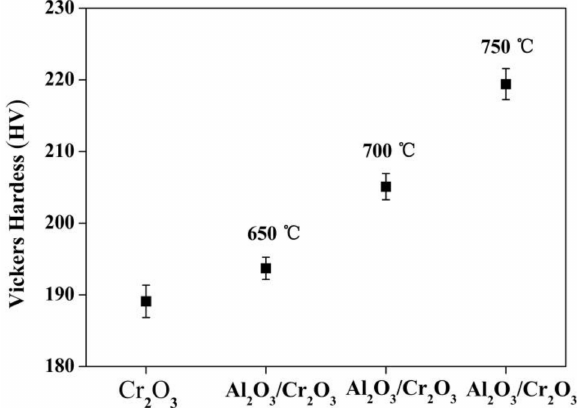
Figure 8. Vickers hardness of Cr 2 O 3 and Al 2 O 3 /Cr 2 O 3 composite coatings heat-treated at different